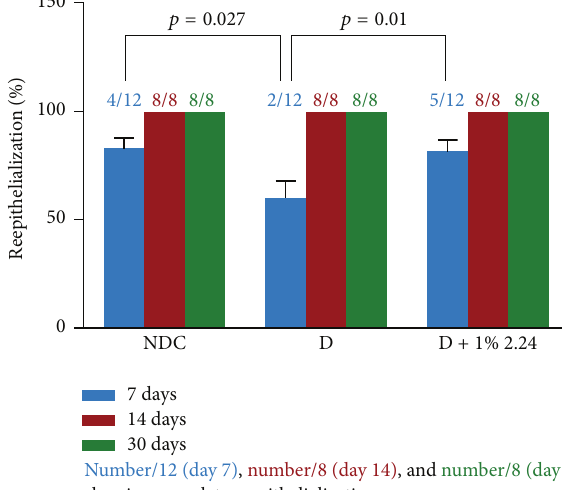
Figure 8: No difference in reepithelialization between normal and diabetic rats skin wound after day 14 administration of 1% topical CMC2.24 and vehicle alone. Day 7: each value represents the mean ± SEM of 12 histomorphometric analyses/group. Day 14: each value represents the mean ± SEM of 8 histomorphometric analyses/group. Day 30: each value represents the mean ± SEM of 8 histomorphometric analyses/group.